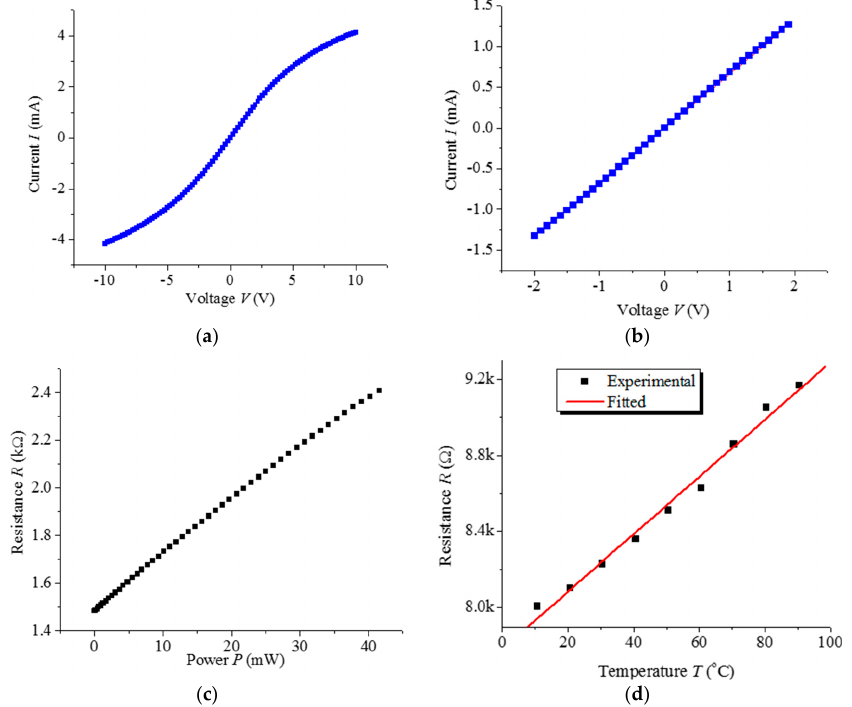
Figure 2. ( a ) The flexual I-V characteristic and the straight line are the experimental measurement of a DWCNT HWA and the theoretical expectation using Ohm’s Law under a bias from − 10 V to 10 V; ( b ) The I-V characteristic of the same specimen with a bias from − 2 V to 2 V. The room temperature resistance of the sensor of this specimen was about 1.5 k Ω ; ( c ) Deduced resistance of DWCNT strand specimen related to applied electrical power; ( d ) Experimental and fitted resistances of another DWCNT strand specimen related to temperature.